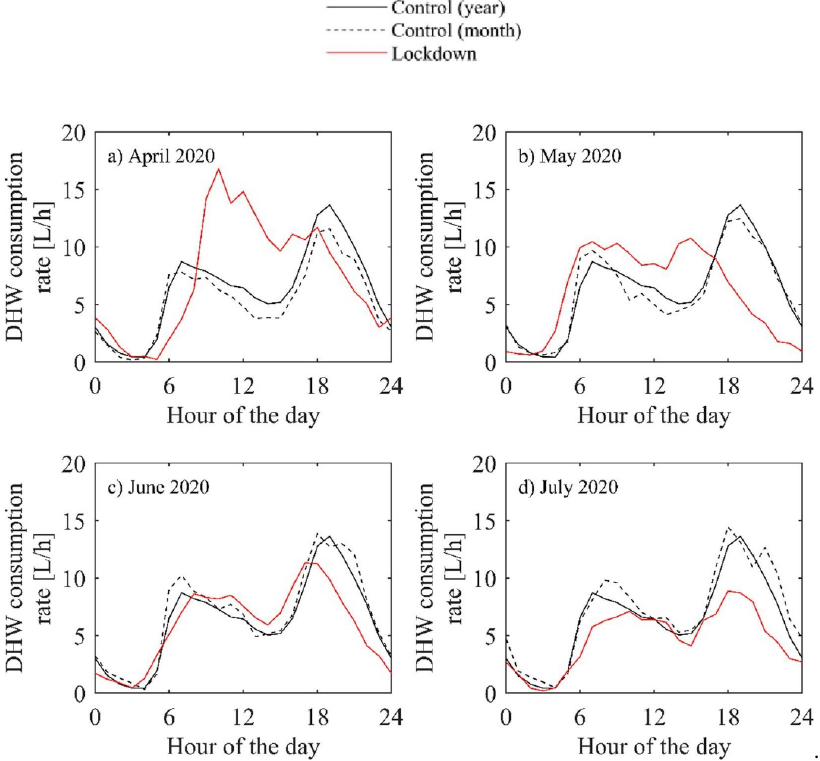
Figure 6. Changes in DHWC during COVID-19, average by month, being: ( a ) April 2020, ( b ) May sion from Elsevier.